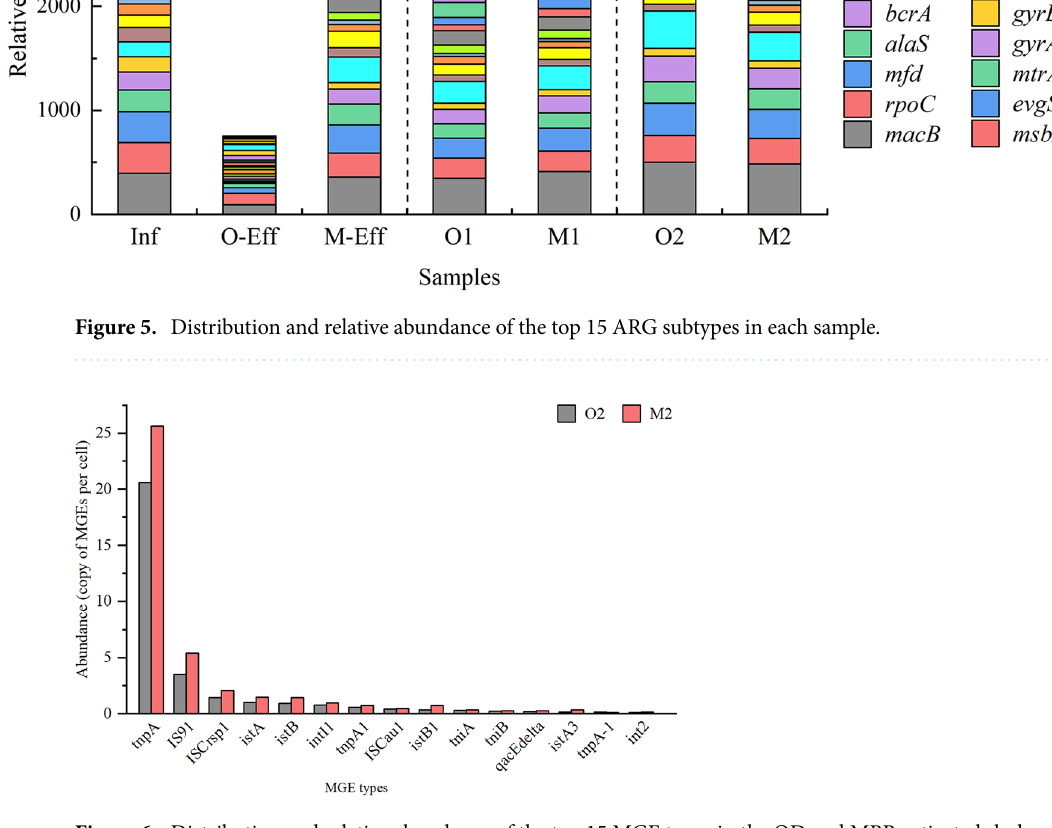
Figure 6. Distribution and relative abundance of the top 15 MGE types in the OD and MBR activated sludge